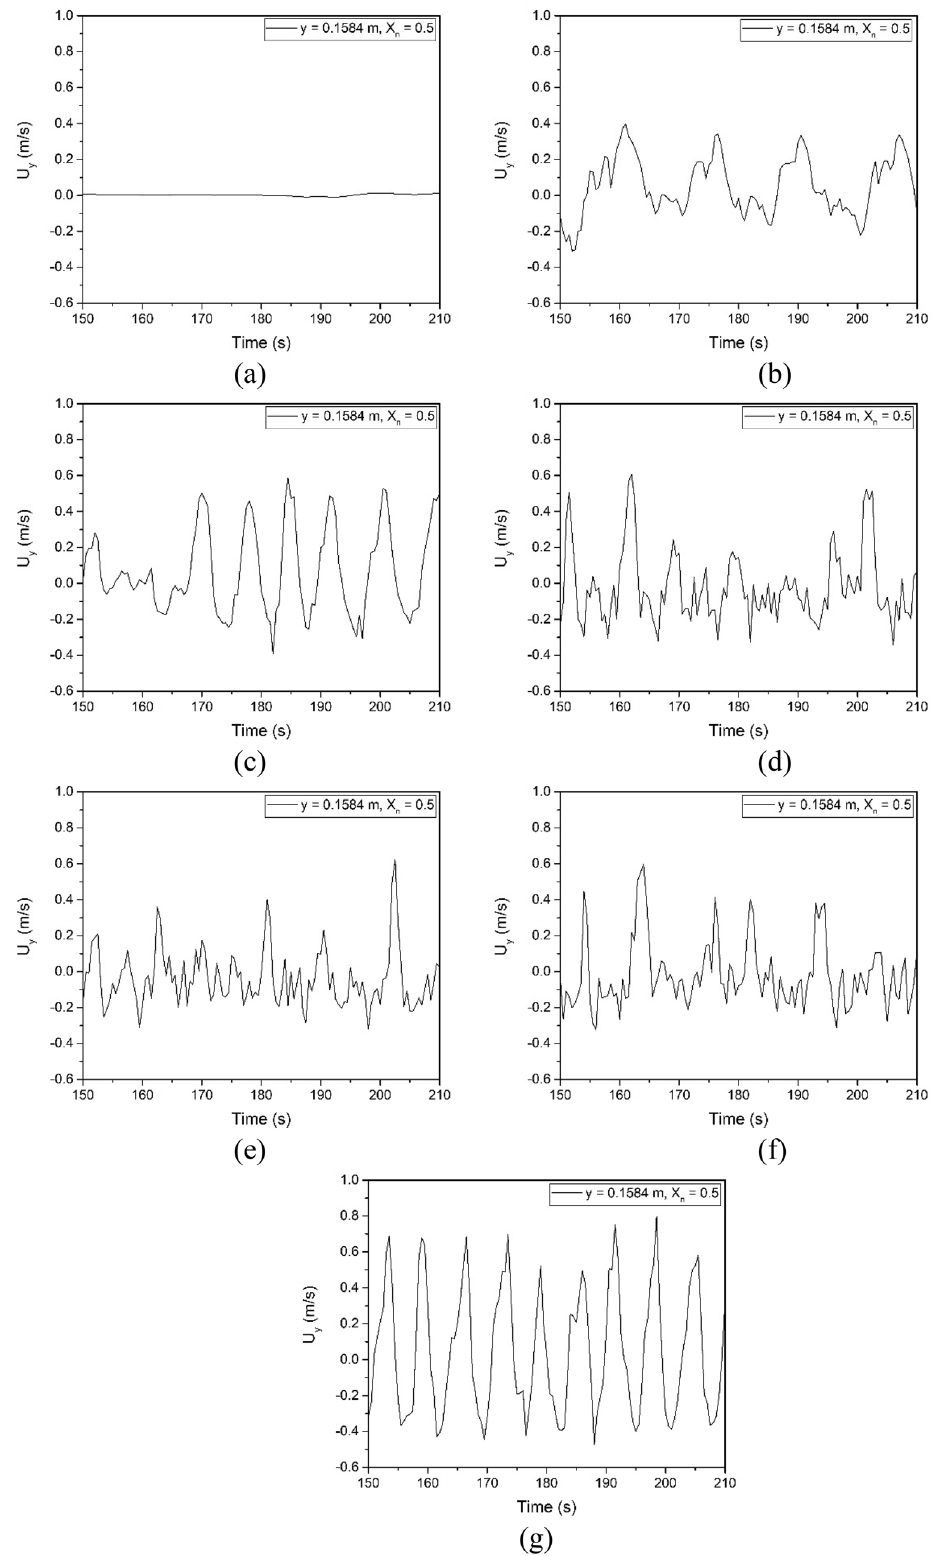
Fig. 9 Vertical liquid velocity fluctuation time series in the column (y = 0.1584, X A3 (85%), d A4 (69%), e A5 (59%), f A6 (44%) and g A7 (18%) (U